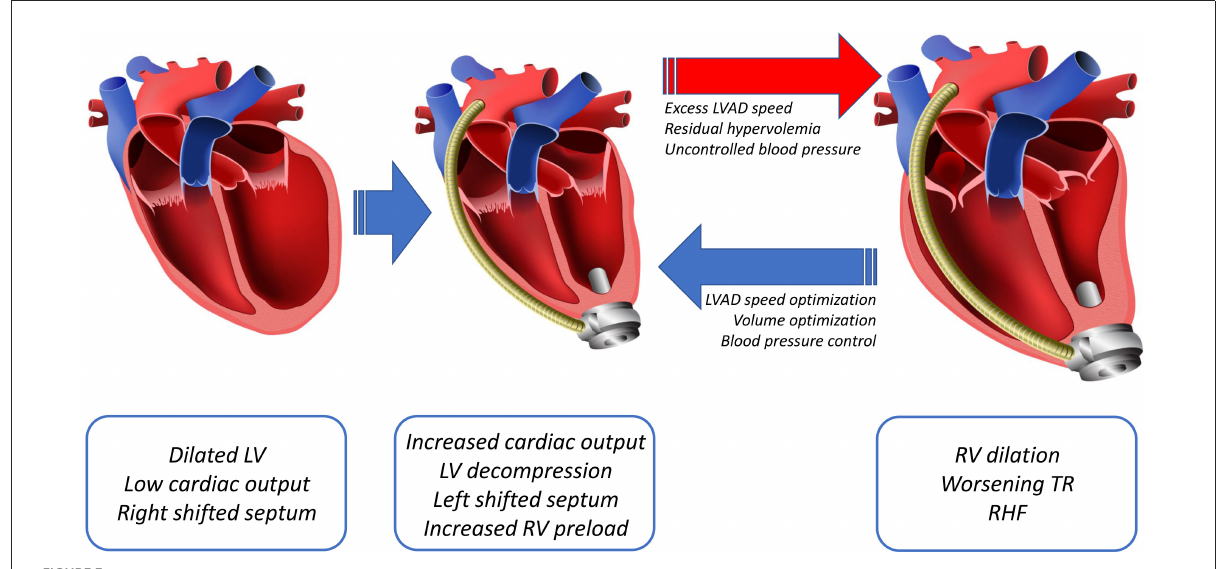
FIGURE3 Diagram showing the main changes post LVAD, including an increased cardiac output that leads to decompression of the LV and a leftward shift of the septum with subsequently increased preload to the RV. The increased right-sided preload and a leftward shift of the septum, dilates the RV, worsening the tricuspid regurgitation (TR), resulting in